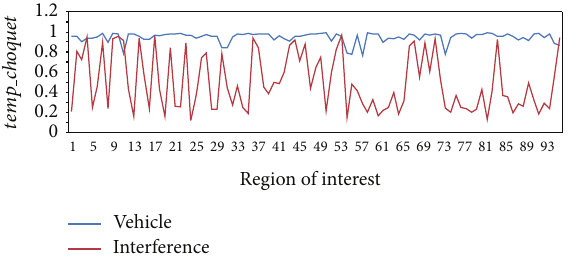
Figure 8: Comparison of temp choquet between the vehicle and the